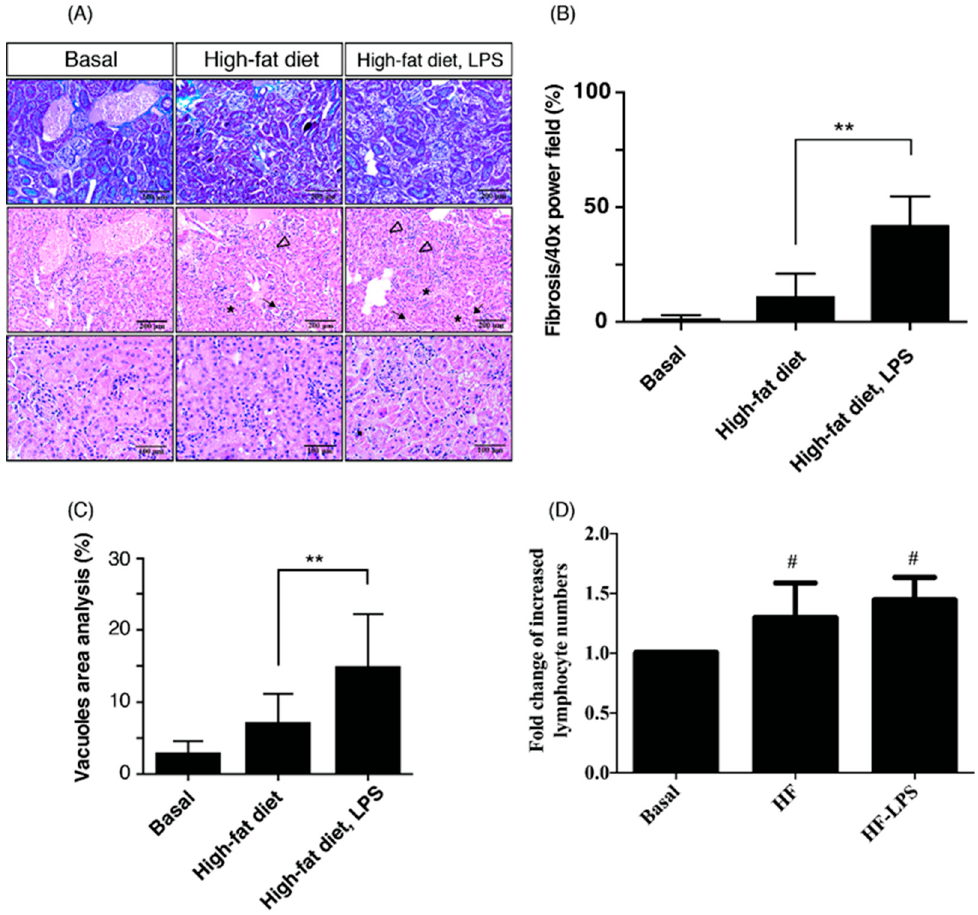
Figure 2. HF mice with ME exhibit the most prominent renal fibrosis, depositions of lipid vacuoles in tubular epithelium, and lymphocyte infiltration in tubulointerstitium. ( A ) Mice were scarified at the end of treatment, and kidney tissues were extracted for histological staining (Haematoxylin and Eosin and Masson’s trichrome staining). Compared with the basal group and HF mice, the HL group exhibited the most prominent renal fibrosis, depositions of lipid vacuoles in tubular epithelium, and lymphocyte infiltration in the tubulointerstitium. Black hollow triangles indicate shedding of tubules. Black arrows indicate infiltration of lymphocytes. Stars indicate lipid vacuoles. Scale bars in the panels are 200 µ m or 100 µ m as indicated. Quantification analyses were performed by ImageJ software for ( B ) fibrosis area ( C ) lipid vacuoles and ( D ) lymphocyte number. Data are expressed as mean ± SD ( n = 8); ** p < 0.01, to compare the differences between the two indicated groups. # p < 0.05, compared with the basal group.